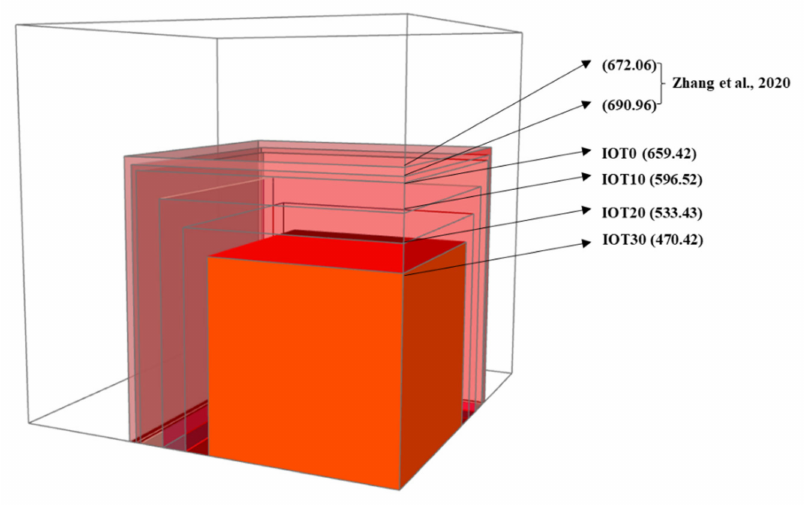
Figure 12. The emission of CO 2 for different UHPC